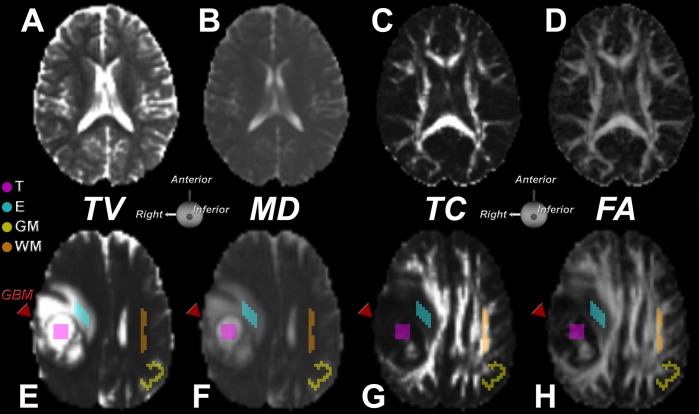
Comparison between toroidal and traditional diffusion tensor maps.Top row shows TV (A), MD (B), TC (C), and FA (D) maps of a mid-axial slice of the brain of a healthy volunteer. In the TV map of the normal brain, a distinction can be made between white matter (WM) and gray matter. The anisotropy coefficient TC displays the WM structure with detail equivalent to the FA map. Bottom row shows TV (E), MD (F), TC (G), and FA (H) maps of a mid-axial slice of a brain containing a GBM (red arrow). The ROIs in the tumor, edema, grey and white matter regions are indicated. The TV map (E) reveals WM information, which is less apparent in the MD map (F). The anisotropy coefficient TC displays some vestiges of WM in the tumor region also evident in the FA map.